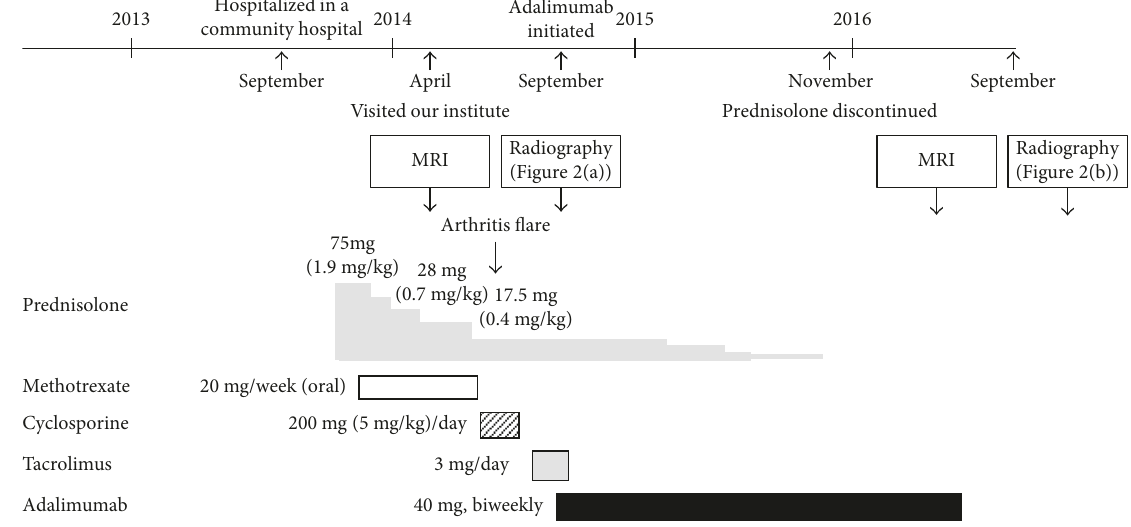
Figure 3: Time course of clinical